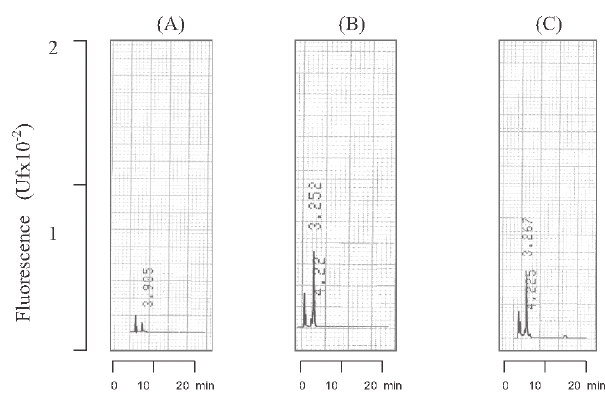
Figure 1 : Chromatographic profiles of plasma propranolol and its internal standard (verapamil). Chromatograms: (A) Normal plasma (B) Lipemic plasma (C) Hemolysate